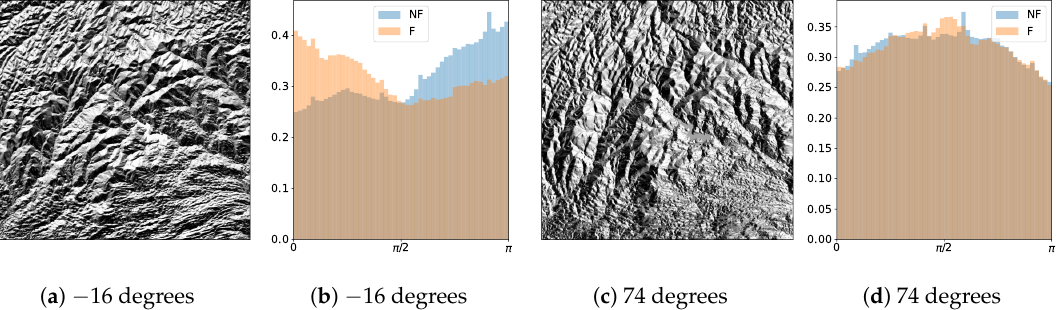
16 ◦ and 74 ◦ , respectively. −